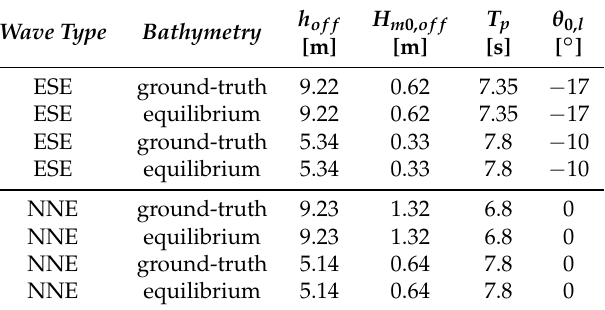
Table 2. Wave characteristics used for the flood simulations.